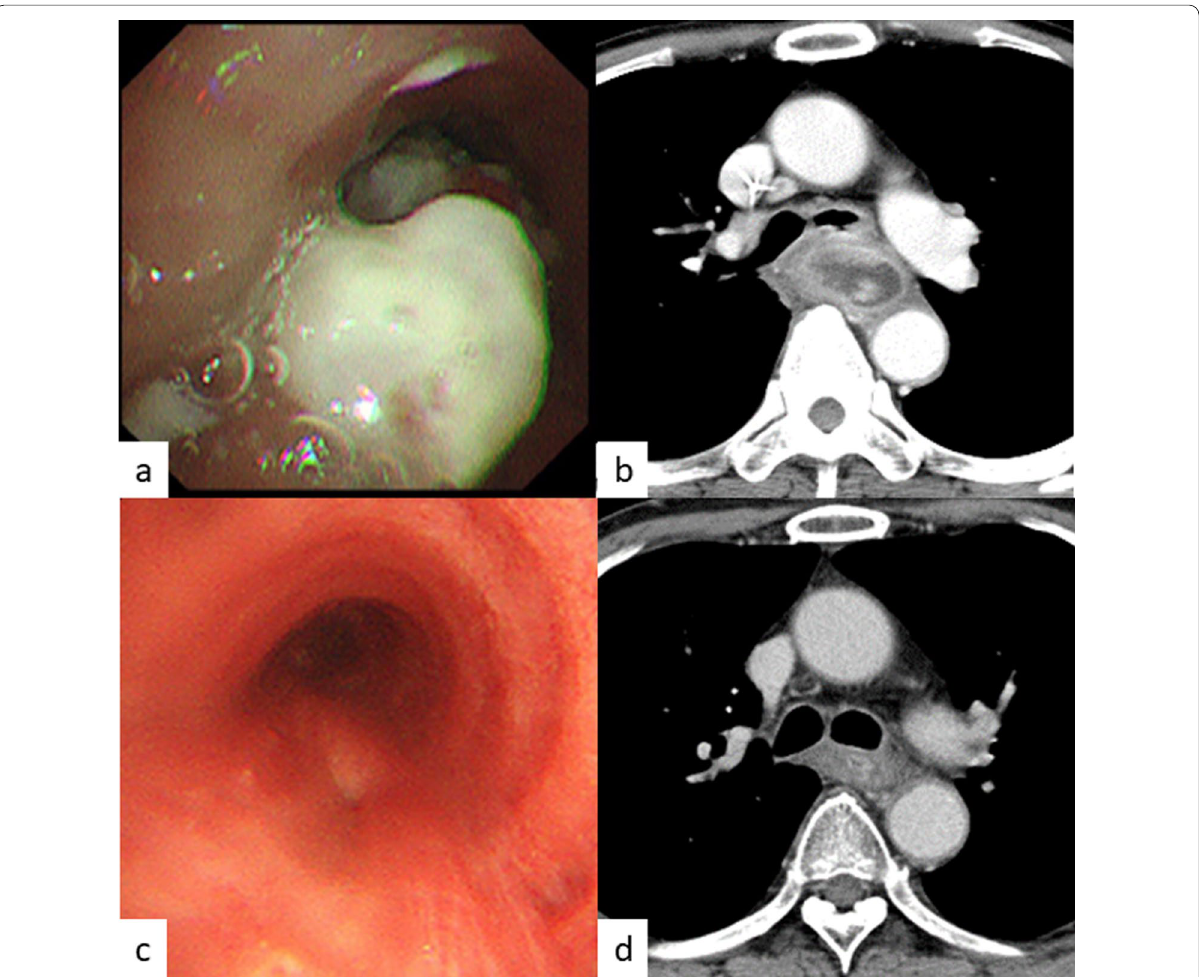
Fig. 2 Images from bronchoscopy and CT. a Before CRT, bronchoscopy shows a white plaque-like erosion at the left bronchus. b Before CRT, CT shows the tumor invading the left bronchus. c After CRT, bronchoscopy shows a slightly depressed lesion. d After CRT, CT shows that the tumor